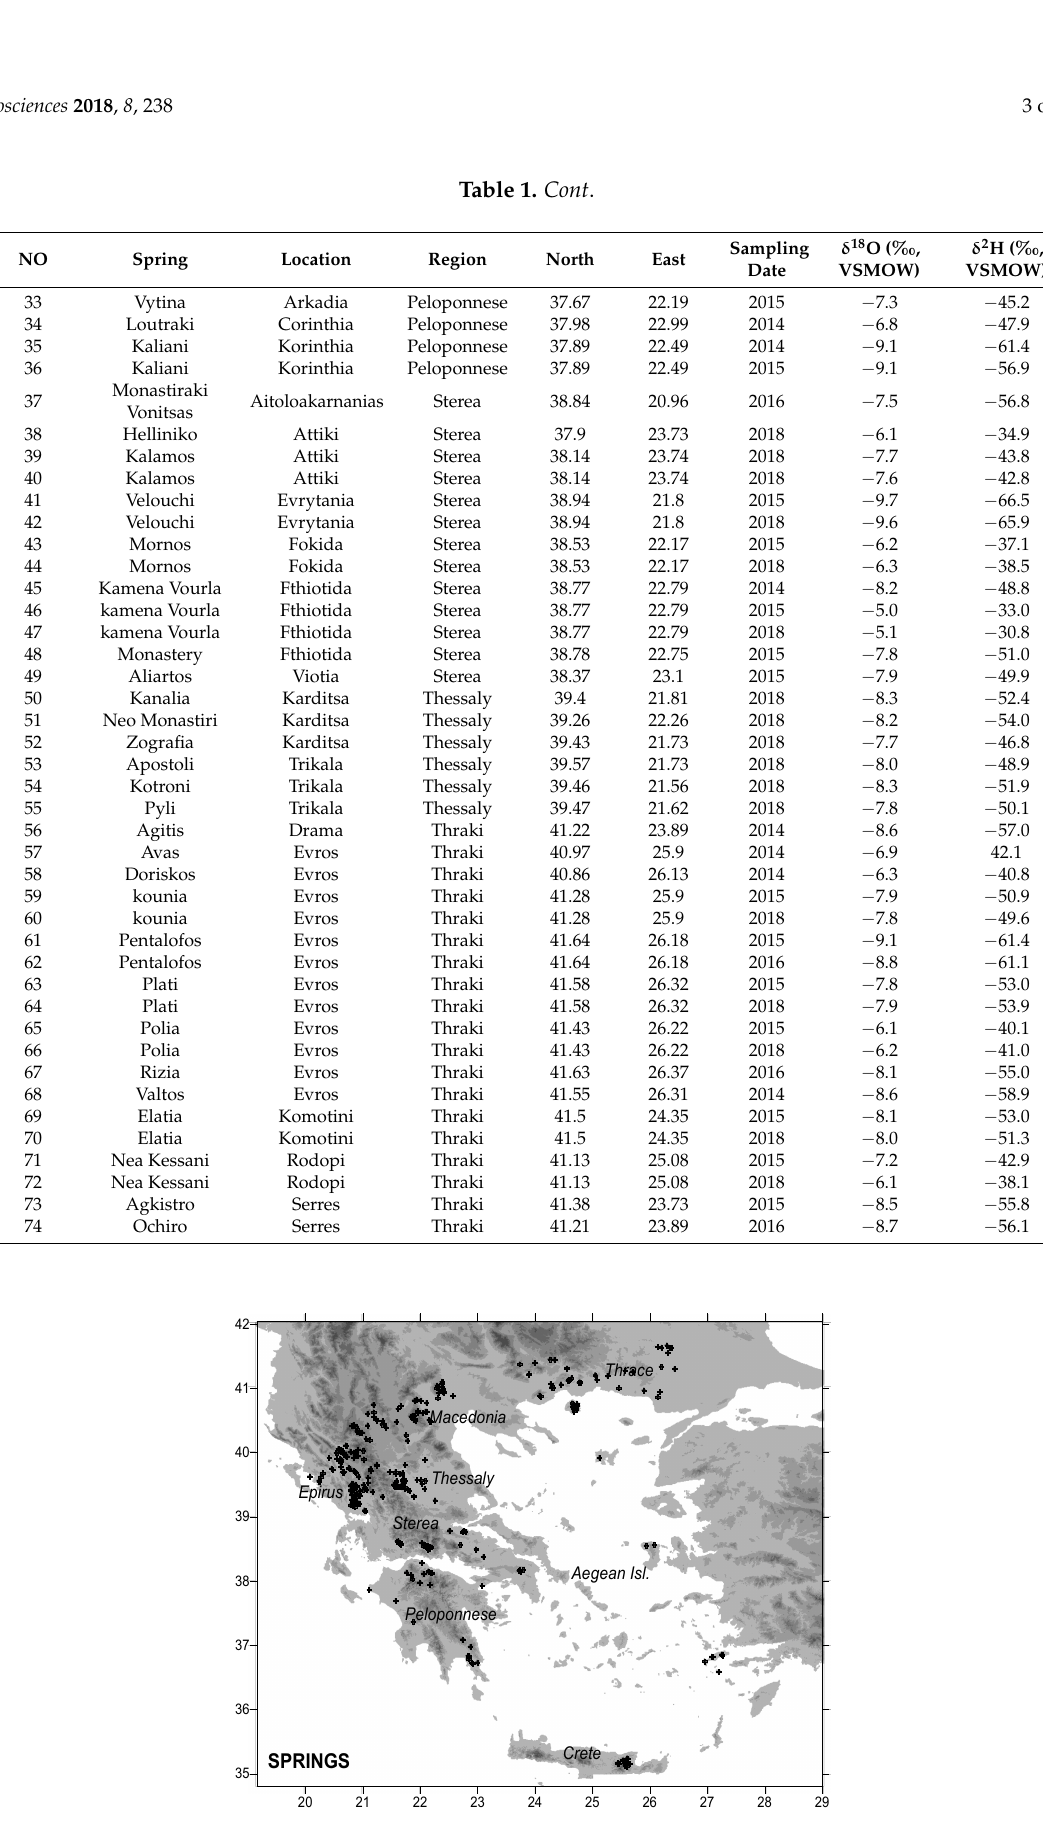
Figure 1. Geographical distribution of the stations considered in this work.